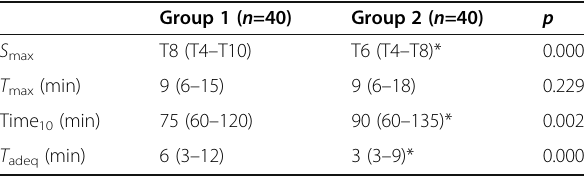
Table 3 Block characteristics in patients with adequate